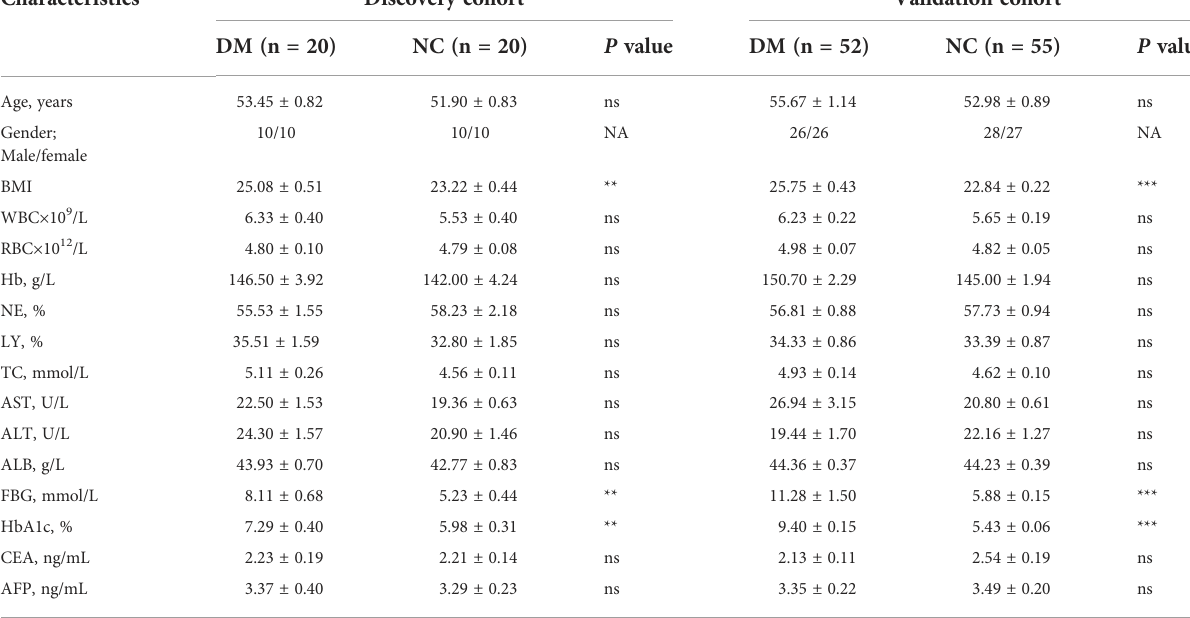
TABLE 1 Demographic and clinical characteristics of diabetic patients (DM) and normal control (NC).